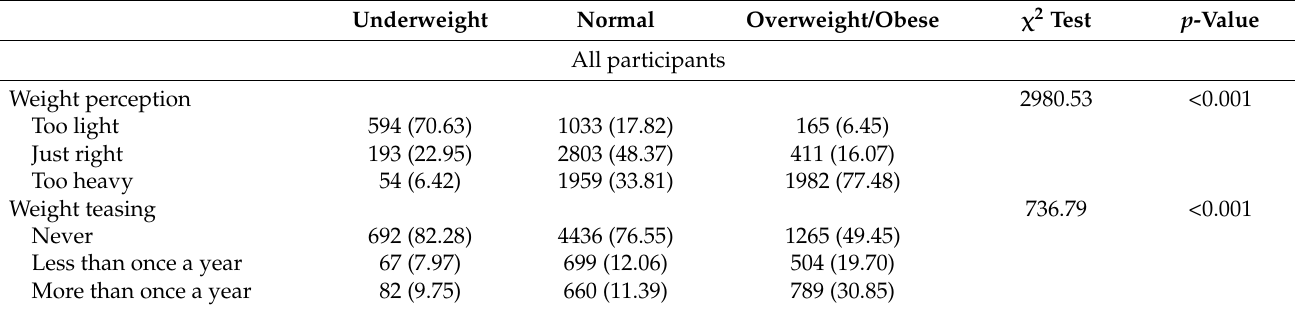
Table 2. Distributions of weight perception and weight teasing among different body weight statuses (BMI) in the whole sample and by sex